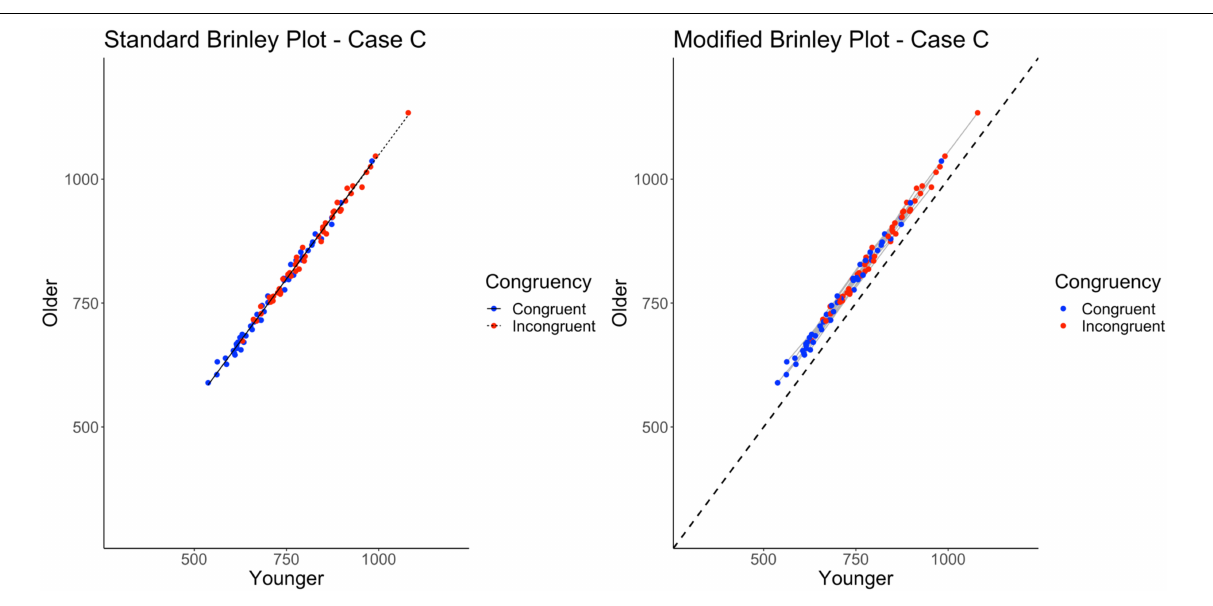
FIGURE 5 | Standard and modified Brinley plots—Case C data. Standard and modified Brinley plots (left and right, respectively) for the Case C simulated data which was simulated such that there was no interaction present. Means (SD) used for Case C were as follows: Young Congruent = 700 (150), Young Incongruent =